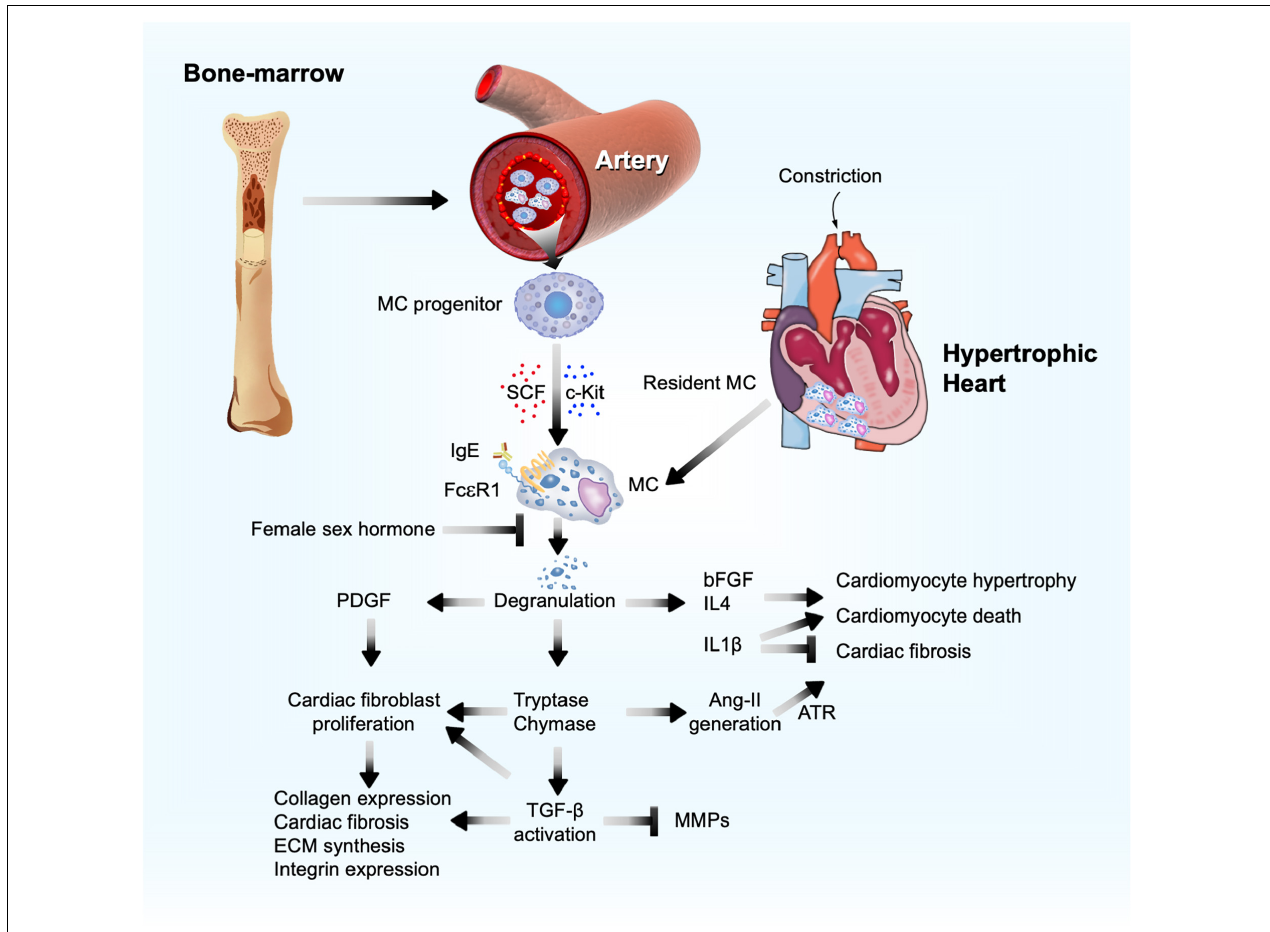
FIGURE 2 | Mast cell function in pressure overload-induced cardiac hypertrophy and fibrosis. Bone marrow MC progenitor-derived and heart-resident MCs get activated and release PDGF, proteases (chymase and tryptase), and cytokines to affect cardiomyocyte hypertrophy, cardiac cell death, and cardiac fibroblast ECM and fibrotic protein syntheses, as a mechanism to promote cardiac hypertrophy and